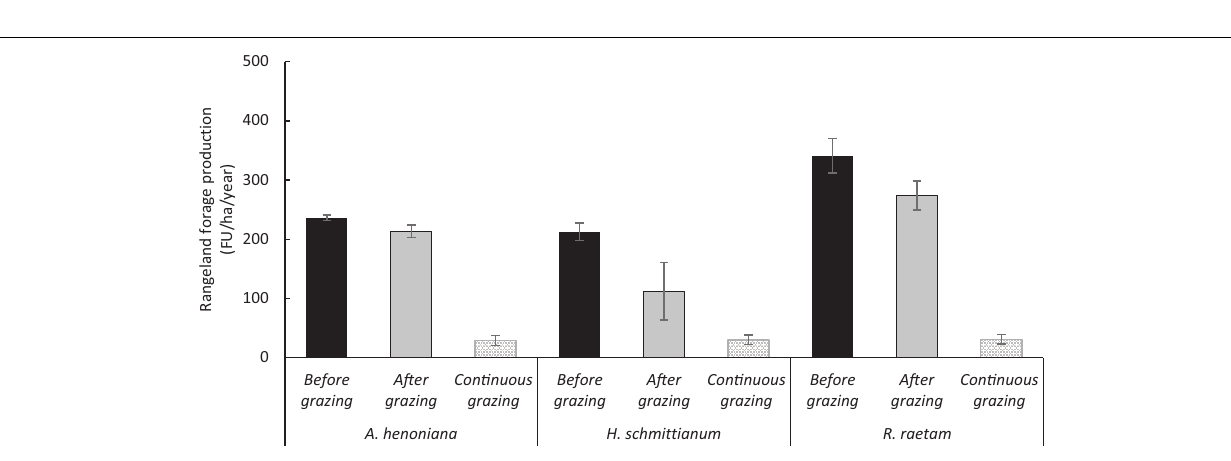
Frontiers in Ecology and Evolution |